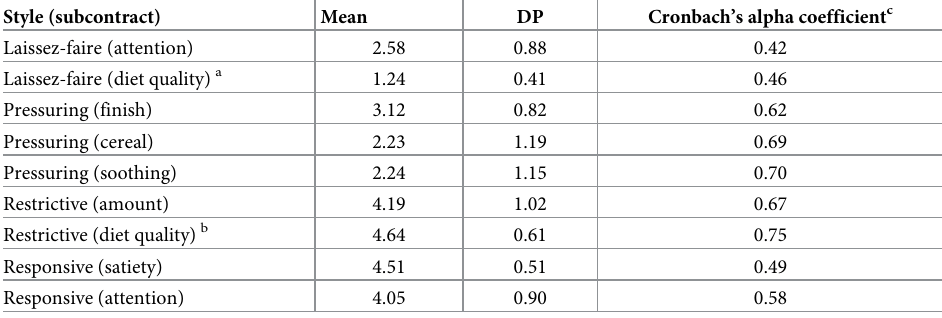
Table 2. Mean, standard deviation, and Cronbach’s alpha coefficient for each sub-construct of Infant Feeding Style Questionnaire. Federal District, Brazil.